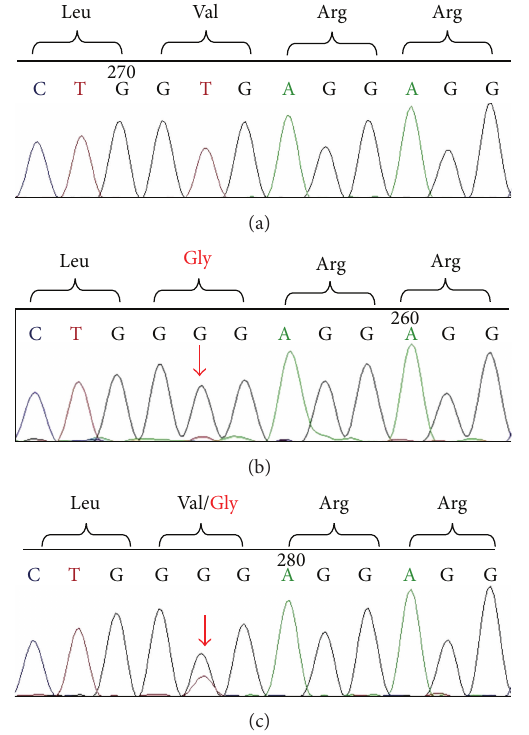
Figure 1: DNA sequencing profiles. Electropherogram profiles of II-4 with a wild type allele (a), II-1 who was a homozygous for the c.1502T > G (b), and I-1 who was a heterozygous for the c.1502T > G (c). The single nucleotide transition at location 1502 bp (c.1502T > G) is indicated by an arrow . The nucleotide change is predicted to cause an amino acid substitution of valine by glycine at residue 501 (p.Val501Gly).